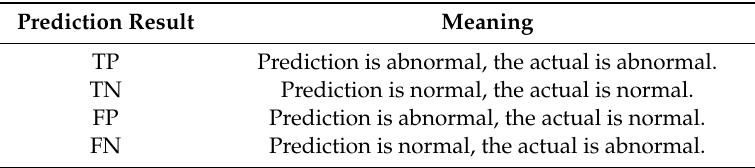
Table 4. Algorithm prediction result and its meaning.